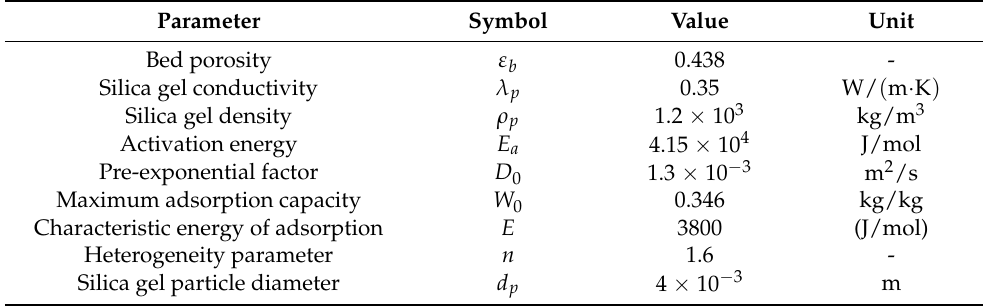
Table 2. Calculation parameters of the numerical simulation and the basic operating conditions of air and water.